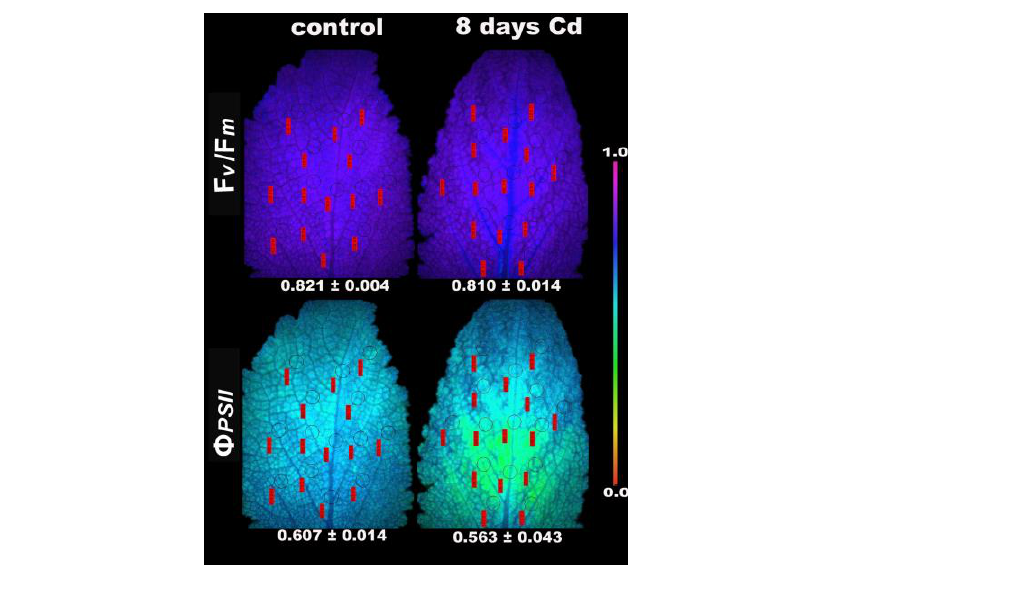
Figure 10. Representative chlorophyll fluorescence images of the maximum efficiency of PSII pho- tochemistry (F v /F m ), and the effective quantum yield of PSII photochemistry (Φ PSΙΙ ) (measured at 220 μmol photons m −2 s –1 ), of S. sclarea leaves from control and 8 days Cd-treated plants. The color code depicted at the right-side ranges from values 0.0 to 1.0. The fourteen circles in each image are the areas of interest (AOI) complemented by red labels with the values of the fluorescence parameter. The average value of each photosynthetic parameter of the whole leaf is presented.